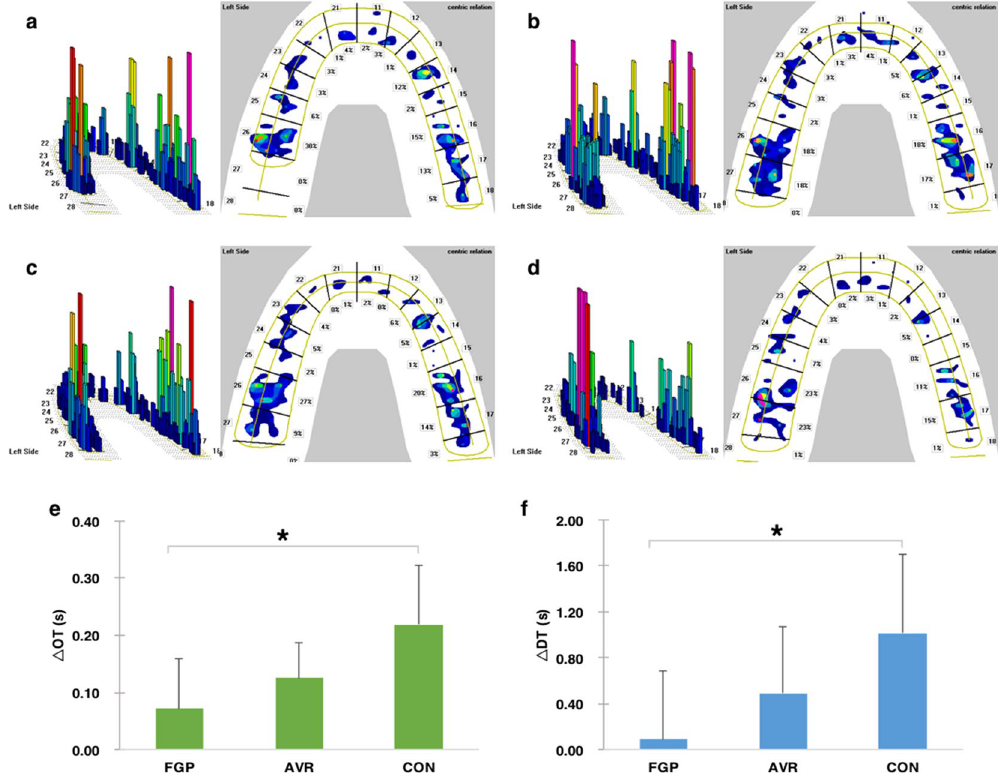
Figure 3. T-scan measurements of the study. ( a – d ) Example of the 2-D and 3-D results of the T-scan measurement. The movie was advanced to the MA frame in which maximum intercuspation occurred. ( a ) The baseline image. ( b ) Try-in of FGP. The force loaded on tooth 26 at baseline distributed equally on tooth 26 and 27 while maintaining almost the same occlusal balance to the baseline. ( c ) Try-in of AVR. Tooth 27 shared part of the force loaded on tooth 26 at baseline. Occlusal balance was maintained. ( d ) Try-in of CON. Occlusal balance was broke. Force concentration area was detected on tooth 27. ( e ) Result of the difference among FGP, AVR and CON in ∆ OT. Significant smaller changes were observed between FGP and CON. ( f ) Result of the difference among FGP, AVR and CON in ∆ DT. Significant smaller changes were observed between FGP and CON.